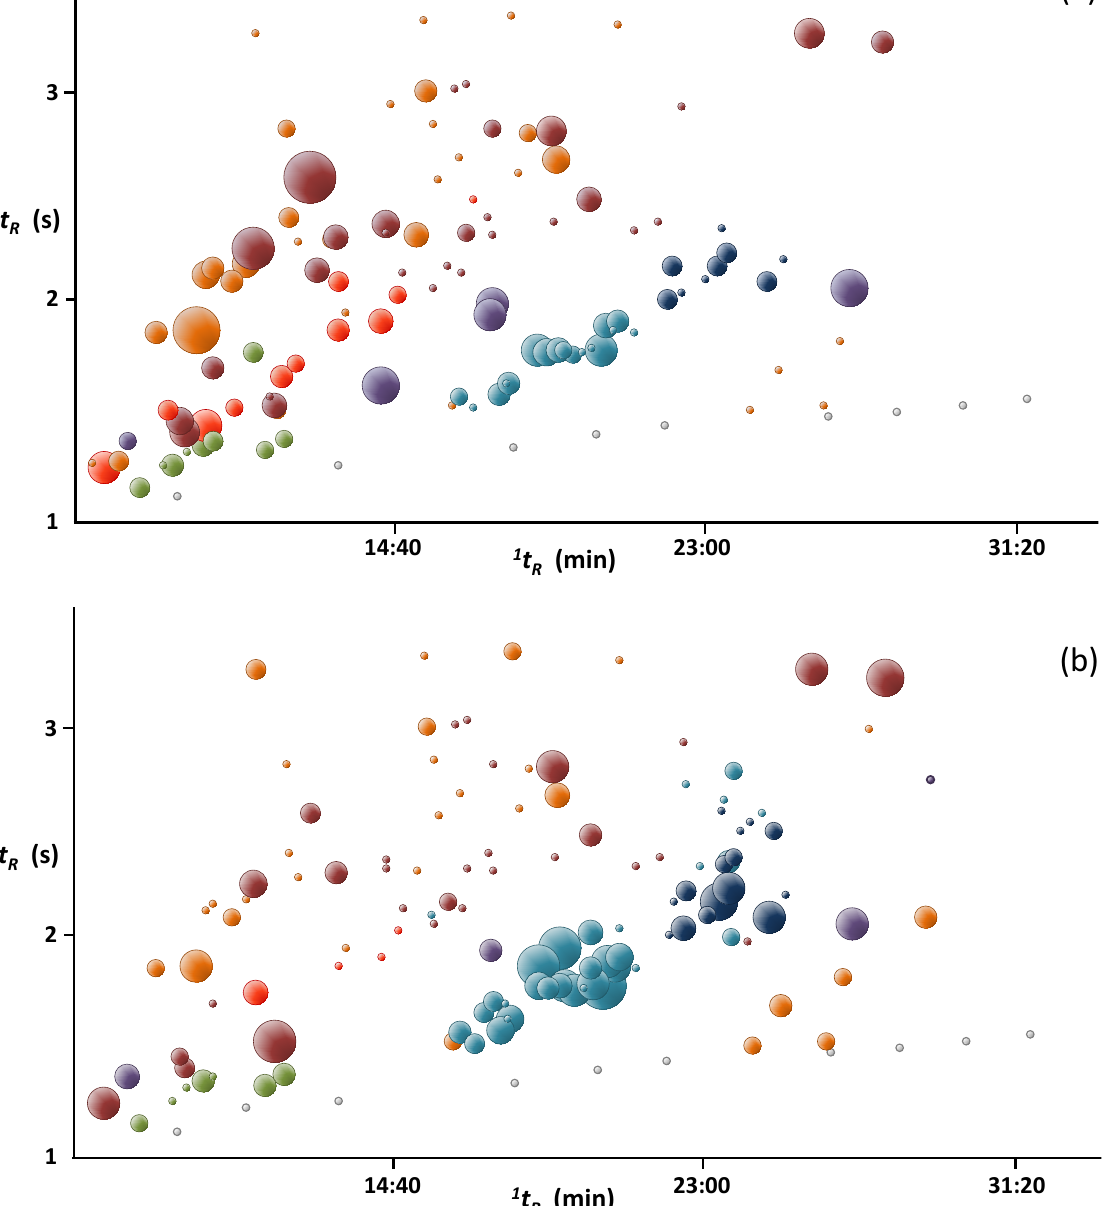
Figure 4. GC×GC bubble plots of two distillate fractions ( a ) collected after 25 min (fraction 1) and ( b ) after 8 h (fraction 4) of distillation of mature ylang-ylang flowers harvested in Mayotte. Chemical classes: alkanes—grey; monoterpenes—green; oxygenated monoterpenes—red; terpenoid esters—purple; sesquiterpenes—light blue; oxygenated sesquiterpenes—dark blue; esters—dark red; others—orange. The size of the bubbles reflects the relative abundances found in Table 1. Alkanes C